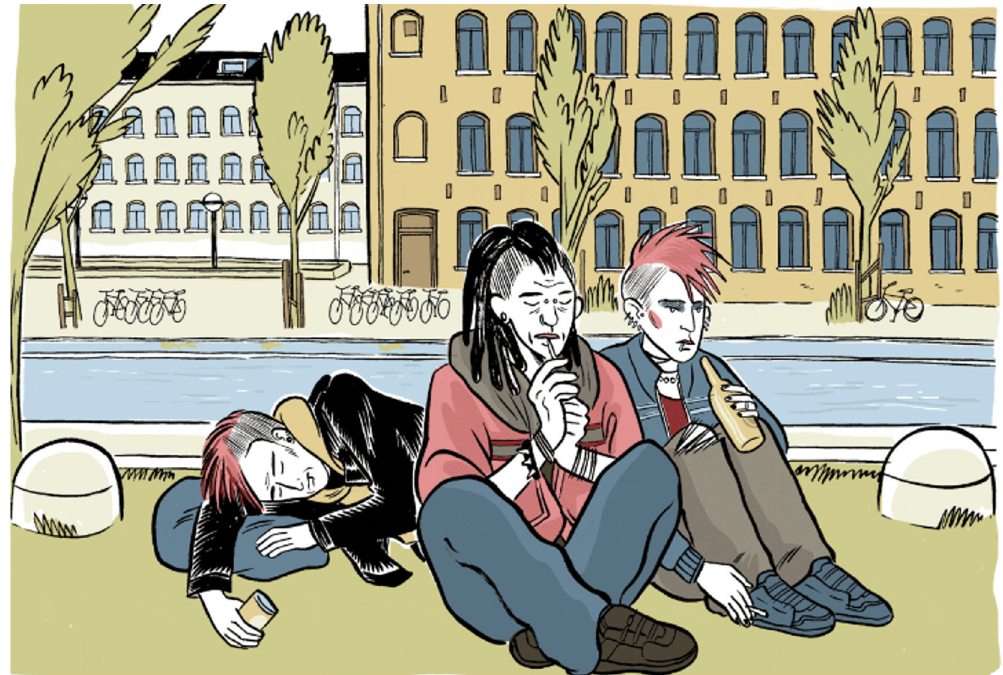
Figure 5: Blurring Lines between Beauty and